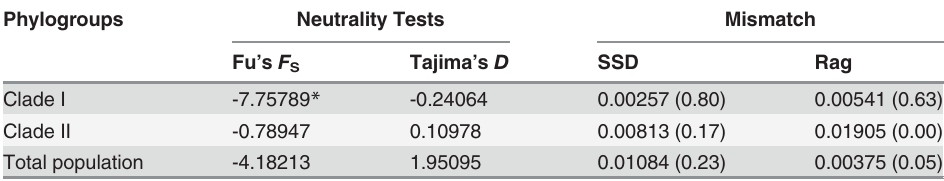
Table 4. Mismatch and neutrality tests results of Spirometra erinaceieuropaei isolates from central and southern China.